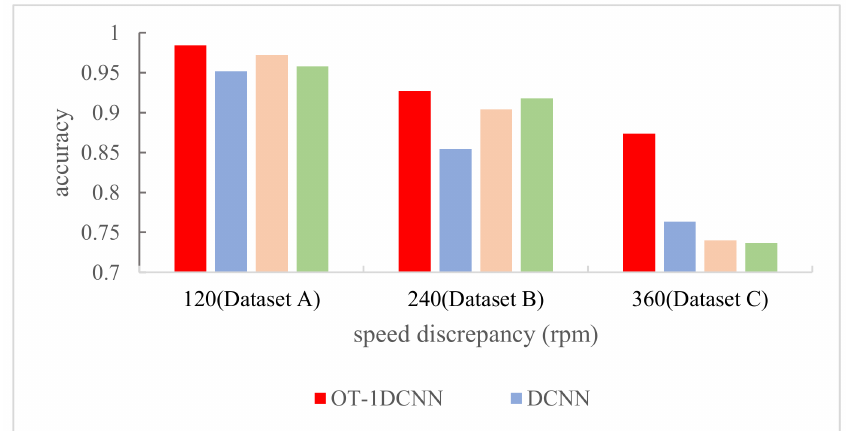
Figure 14. The results of comparative experiments with self-made